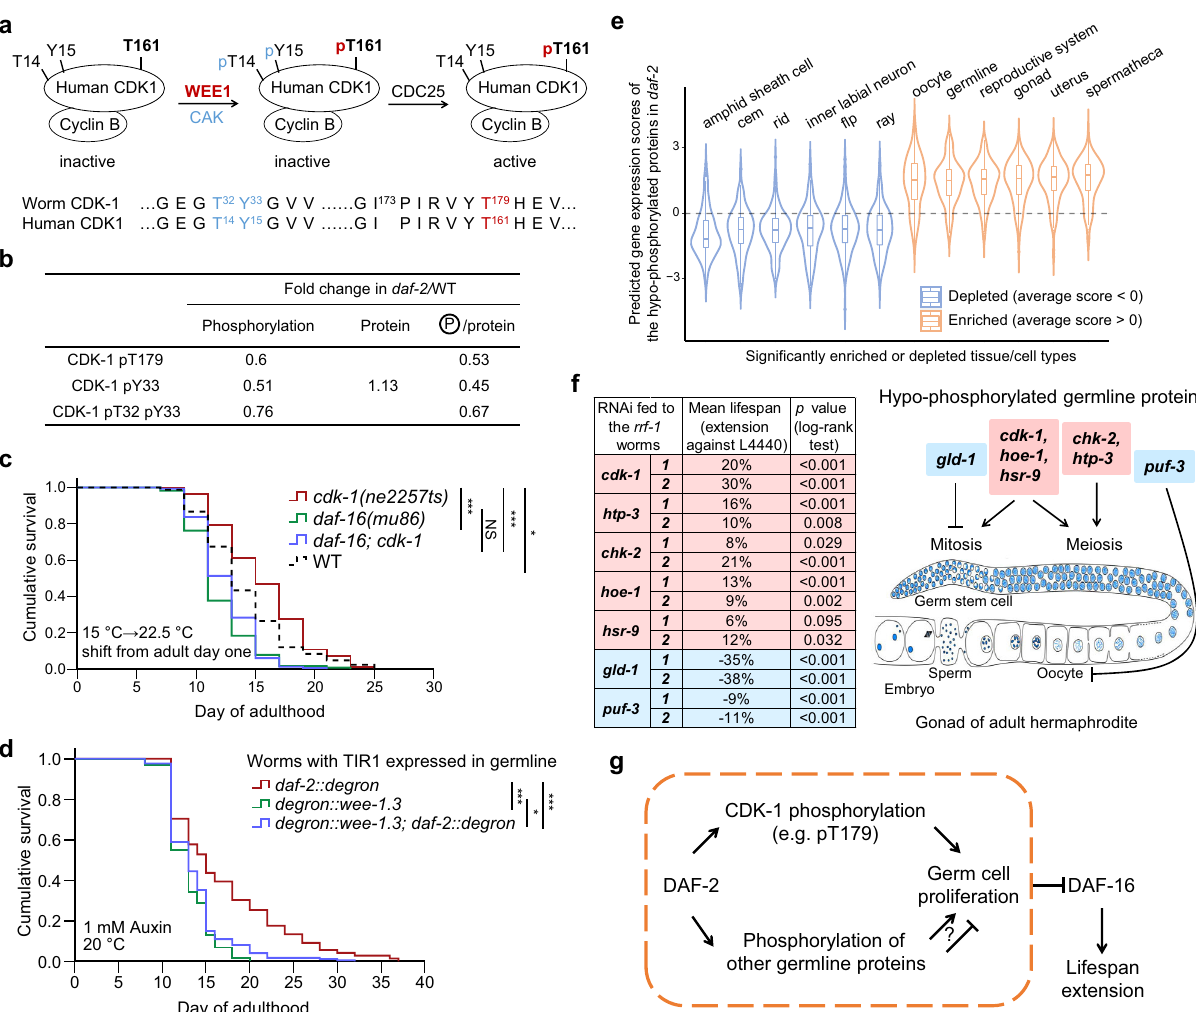
Fig. 5 CDK-1 pT179 and other germline phosphoproteins contribute to lifespan determination. a Model shows the human CDK1 activity regulated through phosphorylation by WEE1 kinase, CAK kinase, and CDC25 phosphatase. Sequences around worm CDK-1 pT32, pY33, and pT179 are identical to that around human CDK1 pT14, pY15, and pT161. Blue, inhibitory phosphorylation. Red, activating phosphorylation. b Phosphoproteomics data show that phosphorylation on CDK-1 decreased in daf-2 worms. CDK-1 protein levels remained similar in WT and daf-2 worms. c Reduction of CDK-1 activity signi fi cantly extended the lifespan of WT worms but did not affect the lifespan of the daf-16(mu86) worms. The ne2257ts[cdk-1-I173F] mutation inactivates CDK-1 at the restricted temperature 22.5°C. d Germline-restricted degradation of WEE-1.3, a negative regulator of CDK-1, signi fi cantly shortened the C. elegans lifespan. Endogenous wee-1.3 and daf-2 were tagged with degron by CRISPR/Cas9. All strains carried the ieSi38[Psun-1::TIR1] allele to induce germline-speci fi c protein degradation upon auxin treatment. Lifespan assays were performed at 20°C, with 1mM auxin supplied from adult day 1. e Top-ranking tissues that were signi fi cantly ( p < 1.0e − 15, two-sided Z test) enriched or depleted for the hypo-phosphorylated proteins in the daf-2 mutant. The predicted gene expression scores across tissues or cell types were derived from Kaletsky et al. 79 . Boxplot shows the fi rst quartile, median, and third quartile of tissue-speci fi c expression scores of the hypo-phosphoproteins ( n = 166). See statistics in Source data. f Germline proteins that were hypo-phosphorylated in the daf-2 mutant participate in lifespan regulation. Individual RNAi clone of genes was fed to the rrf-1(pk1417) worms from adult day 1 at 20°C and assayed in two independent trials. L4440 is the empty vector control. Red highlights the pro-reproduction and anti-longevity genes. Blue highlights the anti-reproduction and pro-longevity genes. The diagram of a gonad was adapted from WormBook 82 . The germline-related phenotypes refer to WormBase release WS275. g A model illustrates dual roles of germline phosphoproteins in mediating the effects of IIS on reproduction and lifespan regulation. * p <0.05, *** p <0.001, NS not signi fi cant, two-sided log-rank test, n >80 worms per strain. See survival statistics in Supplementary Dataset